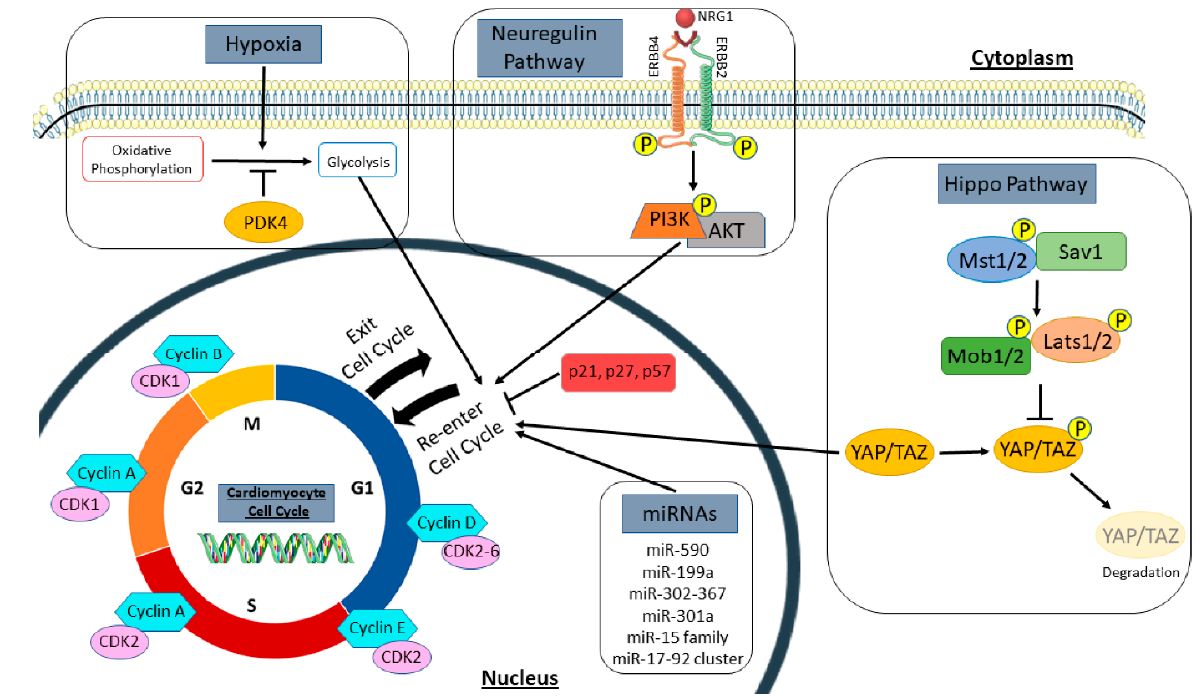
Figure 1. Regulators of the cardiomyocyte cell cycle. Summary of signaling pathways, cell cycle genes, and extracellular stimuli that induce cardiomyocyte proliferation, as discussed in this review. This includes cell cycle promotors and inhibitors, both the hippo and neuregulin pathways, microRNAs, and metabolic regulators, such as hypoxia and PDK4. Cyclins and cyclin-dependent kinases promote cell cycle activation and progression, while cyclin-dependent kinase inhibitors such as p21, p27, and p57 inhibit the cell cycle. In the hippo pathway, activation of upstream kinases (Mst1/2, Sav1, Mob1/2, and Lats1/2) phosphorylate the downstream transcription co-activators (YAP/TAZ) to promote their degradation. However, inactivation of upstream kinases causes YAP/TAZ to translocate to the nucleus to promote cell cycle re-entry in cardiomyocytes. Neuregulin (NRG1) binds to its tyrosine receptor subunits (ERBB2 and ERBB4) to activate a downstream signaling pathway (PI3K/AKT) and induce myocyte proliferation. Several microRNAs (miRNAs) also regulate the cell cycle to influence new myocyte formation. Hypoxia and PDK4 lead to a metabolic switch in cardiomyocytes from mitochondrial oxidative phosphorylation to anaerobic glycolysis for energy production. This metabolic change influences cell cycle activation in cardiomyocytes. PDK4, pyruvate dehydrogenase kinase 4.